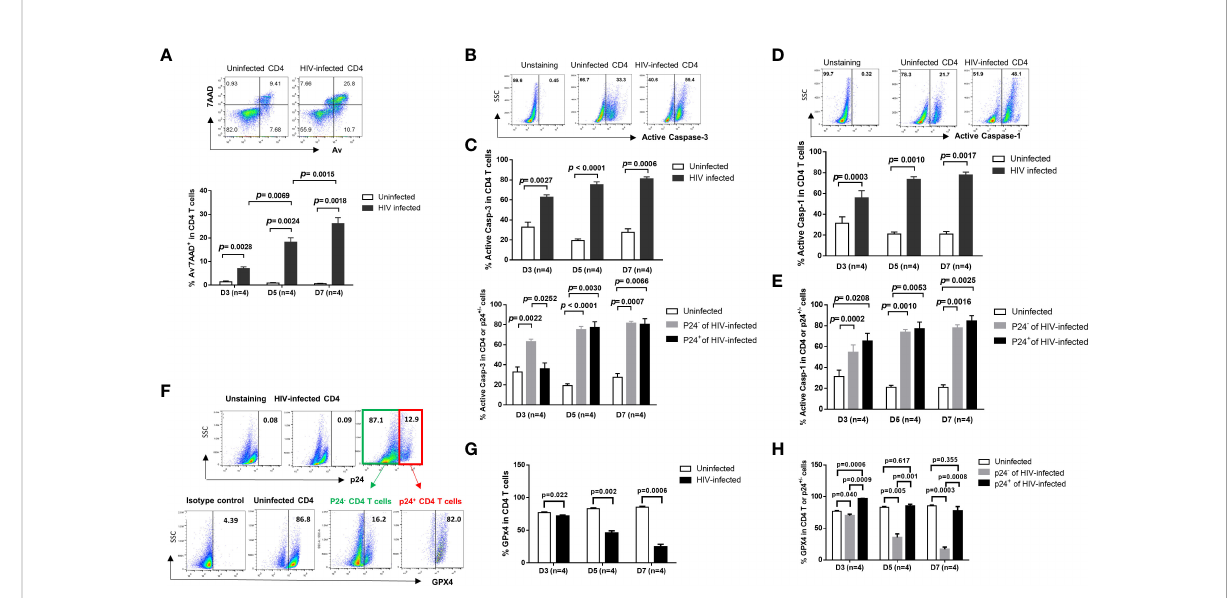
FIGURE 1 HIV induces CD4 T cell death in productively infected and bystander cells during early infection via different mechanisms. (A) Representative dot plots (day 7) and summary of the percentage (%) of Av and 7AAD levels in HIV-infected and uninfected CD4 T cells, as determined by fl ow cytometry. (B, C) Representative dot plots and summary data showing active caspase-3% in productively HIV-infected (p24+) and bystander (p24-) or uninfected cells at days 3, 5, and 7 in cultures. (D, E) Representative dot plots and summary data of active caspase-1% in HIV-infected (p24+) and bystander (p24-) or uninfected cells at day 3, day 5, and day 7. (F – H) Representative dot plots and summary data of GPX4% in HIV- infected (p24+) and bystander (p24-) or uninfected cells at days 3, 5, and